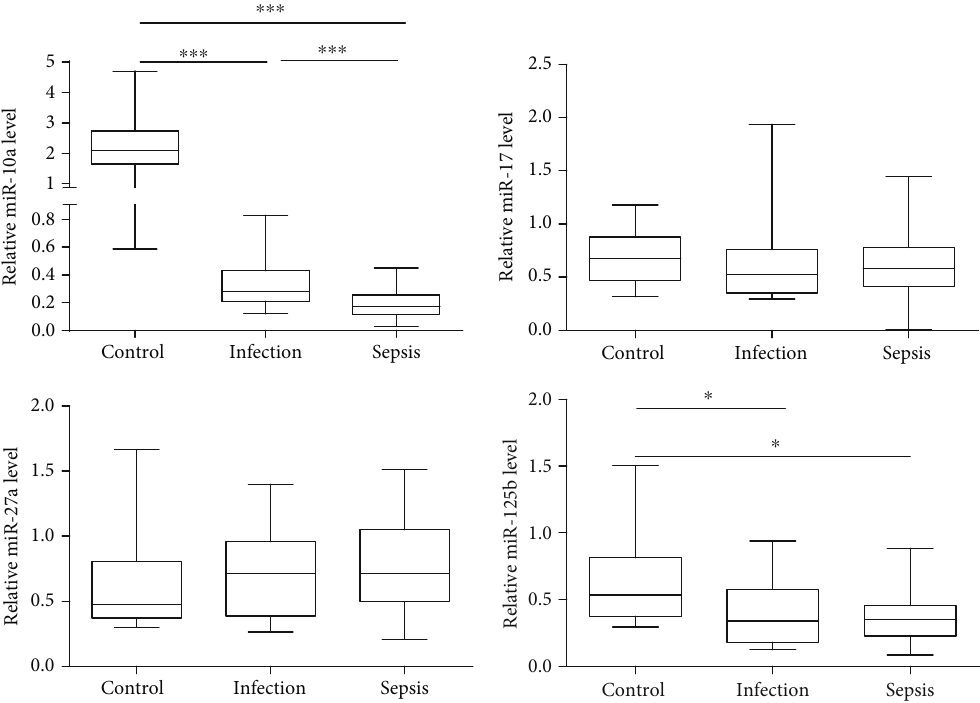
Figure 1: PBMC miR-10 levels in sepsis. The box and whisker plots represent the levels of miR-10a, miR-17, miR-27a, and miR-125b in PBMC of healthy controls ( n = 20 ), infection patients ( n = 21 ), and sepsis patients ( n = 41 ). The plot shows the median (lines within boxes), interquartile range (bounds of boxes), and error bars (upper and lower ranges). ∗ p < 0 : 05 and ∗∗∗ p < 0 : 001